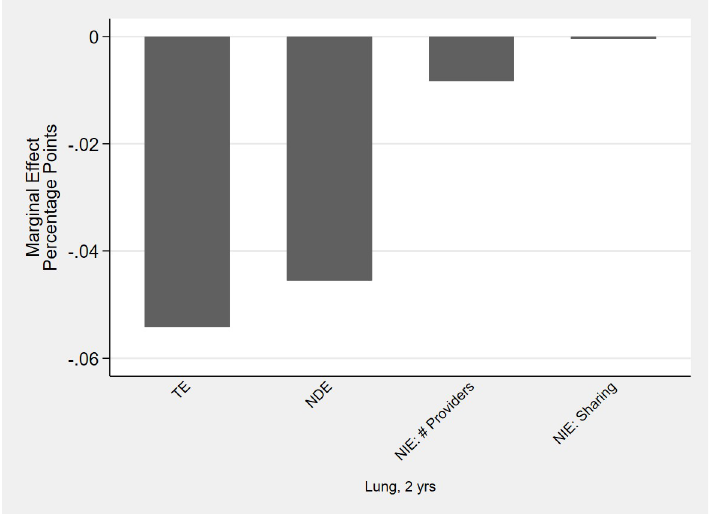
Fig 4. Effects of cancer on proportion adherent (proportion of days covered > 80%) for statins: Total Effect (TE), Natural Direct Effect (NDE) and Natural Indirect Effect (NIE) through number of providers and sharing amongst providers. Point estimates, in percentage point changes, for cancer sites and phases of care with statistically significant total and net indirect